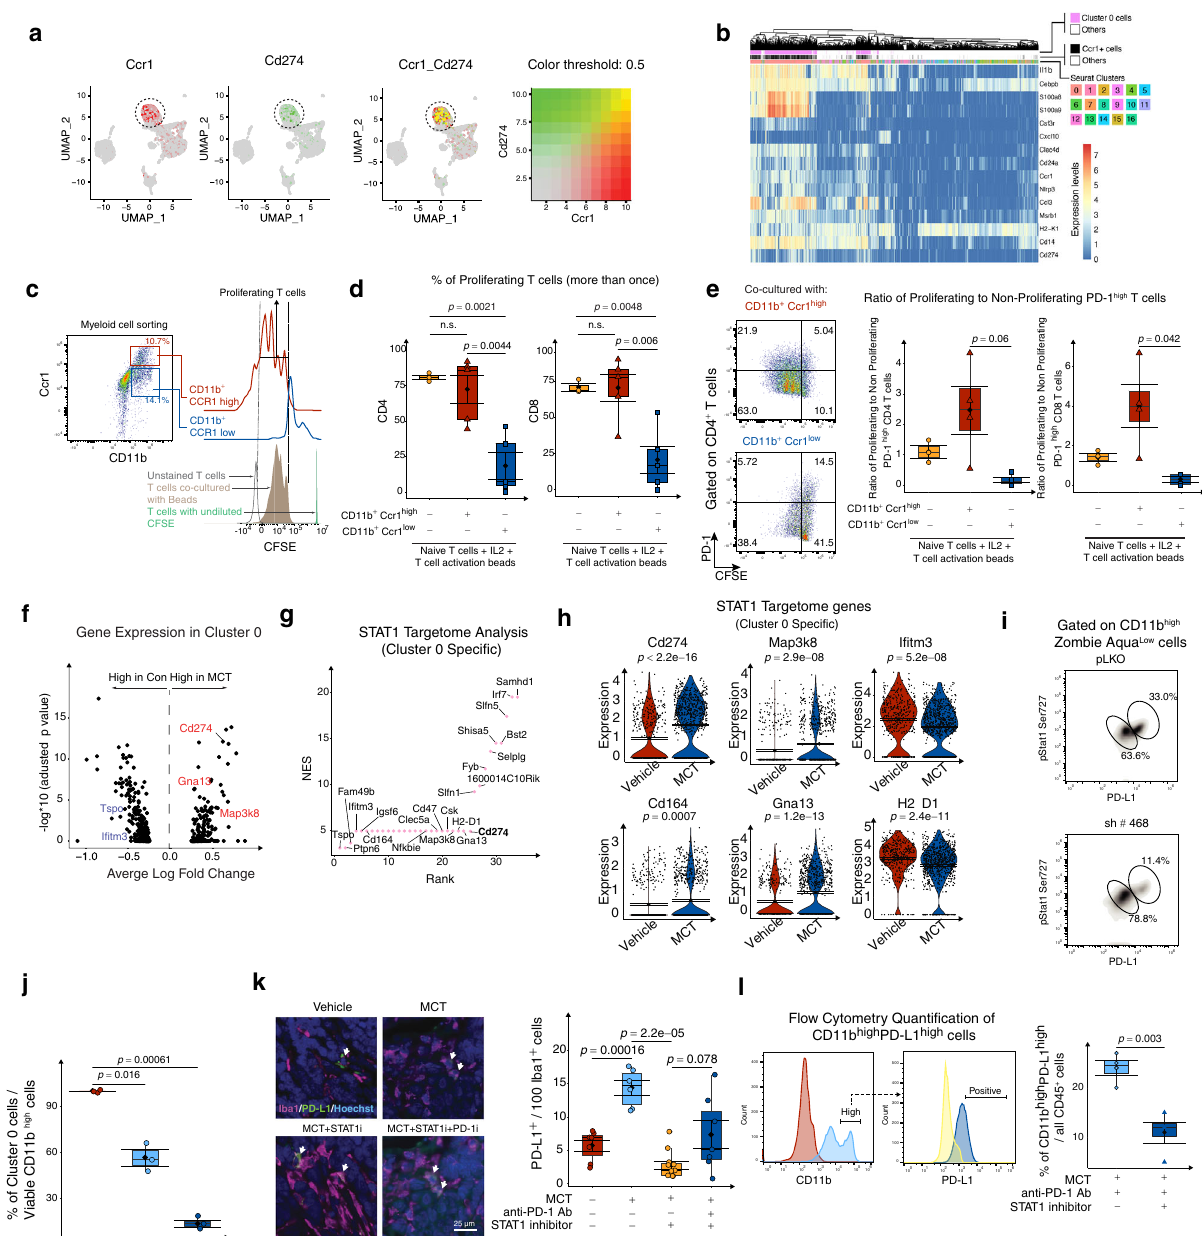
Fig.5|STAT1regulatesPD-L1expressioninCluster0cellsandin fl uencesT-cell activationstatus.a DualplotshowsexpressionofCcr1andCd274inimmunecells. b Heatmap shows the marker genes of Cluster 0 and compares their expression between Ccr1 + cells, Cluster 0, and other myeloid cell subsets. c Gating strategy to identify FACS sorted CD11b high CCR1 high , CD11b high CCR1 low myeloid cells, and CFSE levels on CD8 + T cells in co-culture. d Box plots show percentage of proliferating CD4 and CD8 T cells in co-culture with T-cell activation beads with or without myeloid cells. e Biaxial plots (left) show the gating strategy to identify the PD-1 levels on CFSE diluted and proliferating T cells. Box plots (right) show the ratio of PD-1 high proliferating and non-proliferating CD4 and CD8 T cells. f Volcano plot showsDGEonCluster0cellswhenMCT-treated. g Scatterplotshowsthepotential gene targets (NES>3 and p <0.05 DEG between MCT and Vehicle treated) in Cluster 0 speci fi c STAT1 targetome. h Violin plots show expression of Cd274, Map3k8,I fi tm3,Cd164,Gna13,andH2-D1genesbyCluster0cells(eachdotisacell andcellsarefrom n =3biologicalrepeatspooledtogether). i Biaxialplotsshowthe